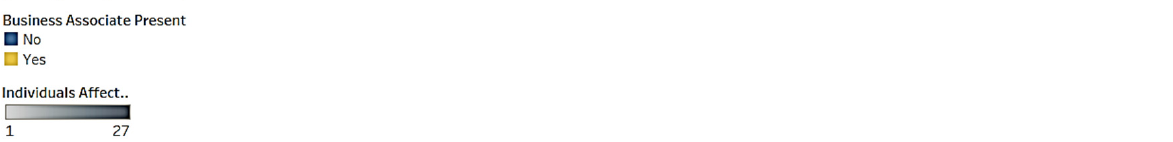
Figure 25. Geographical distribution of affected individuals’ business associate presence.